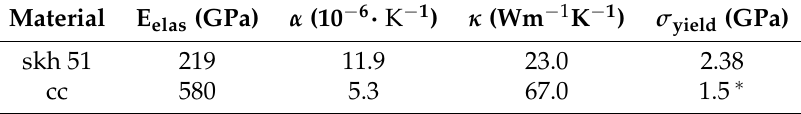
Table 2. Material constants. E elas : Elastic Modulus; α : Thermal Expansion; κ : Thermal Conductivity; σ yield : Yields Stress. * cc shows brittle fracture characteristic and the value listed below as the yield stress is actually the ultimate